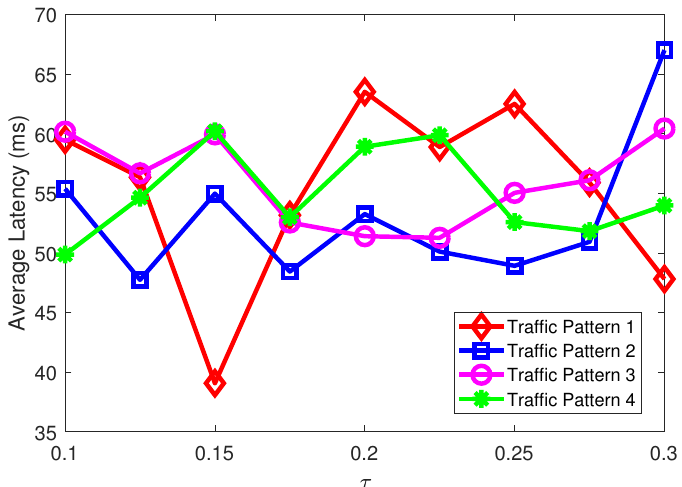
Figure 15. Impact of τ on average latency in